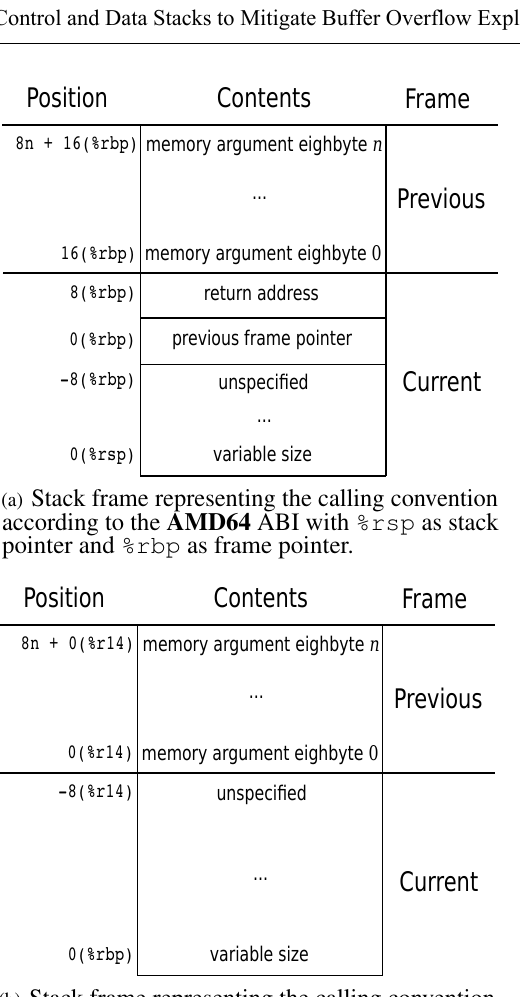
Figure 17. Calling conventions of AMD64 and